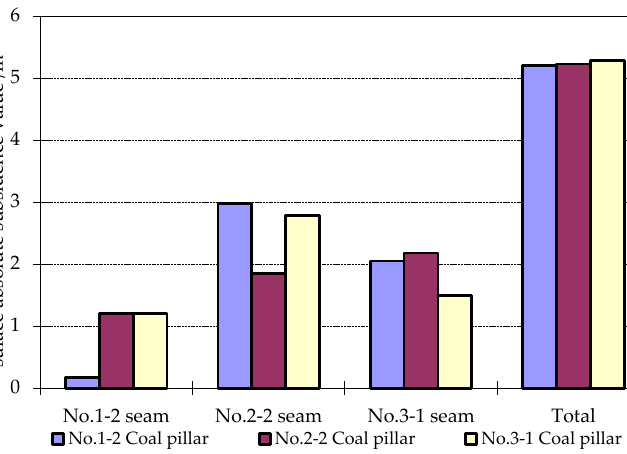
Figure 21. Absolute subsidence value in coal pillars position after multiple-seam mining.